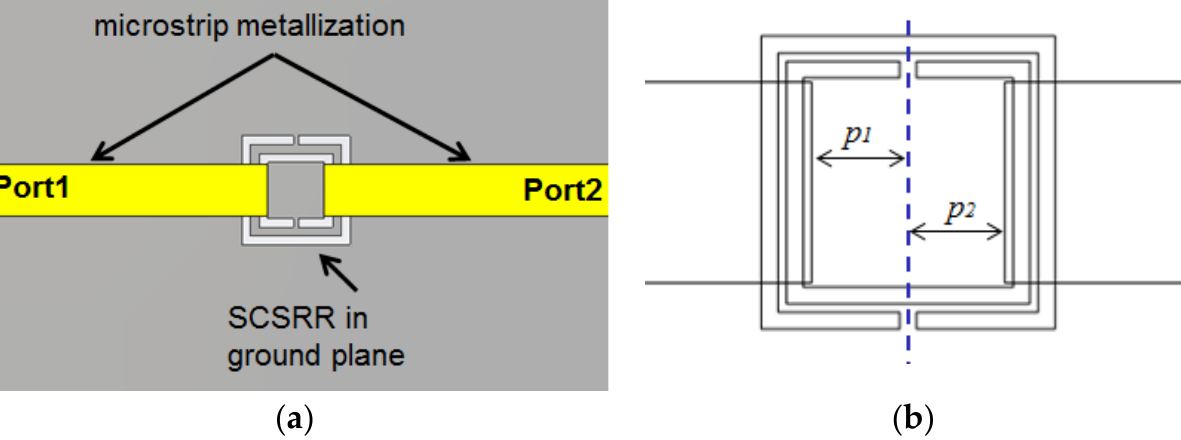
Figure 2. ( a ) Layout of the SCSRR resonator. ( b ) Detailed parameters p1 and p2 to build the open stub.